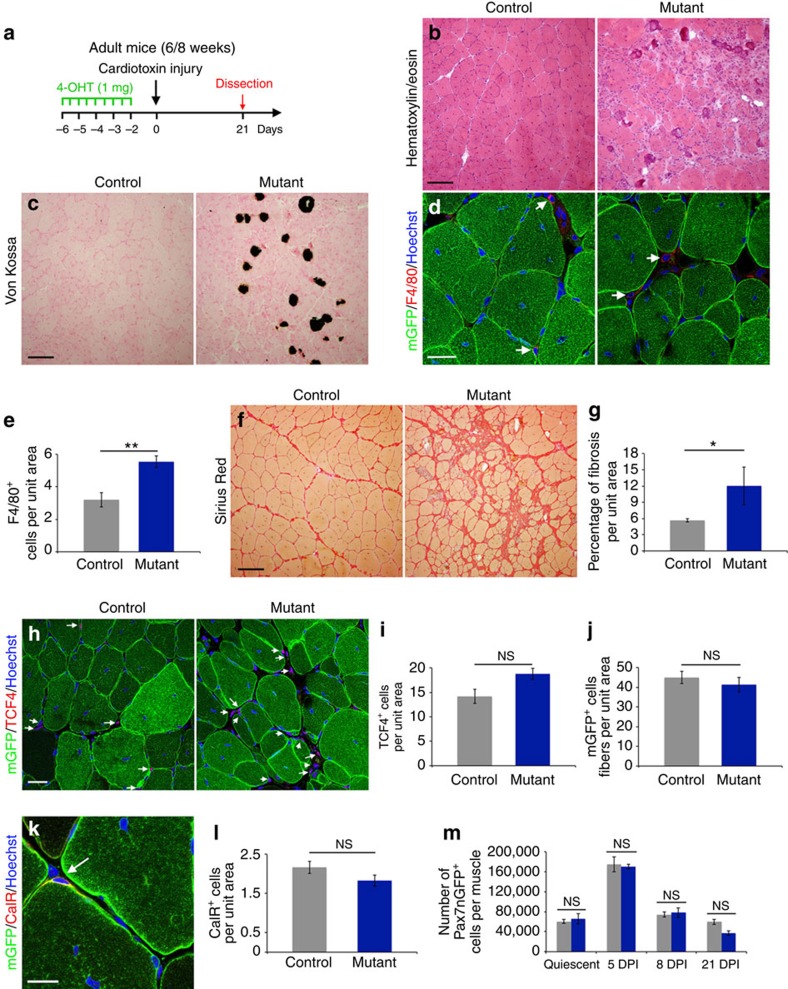
Incomplete regeneration following deletion of Numb:Numbl in satellite cells.(a) Strategy used to study TA muscle regeneration in the context of Numb:Numbl depleted satellite cells. Data were collected from transverse TA muscle cryosections of adult mice. (b) Histological staining with H&E. (c) Histological staining with Von Kossa. Dark precipitates reveal calcium deposits, a sign of chronic inflammation. (d) Immunofluorescence staining for macrophages (arrows) using anti-F4/80 antibody. (e) Quantification of the number of macrophages in (d); control: n=5 mice, 3.2±0.4 cells per unit area; mutant: n=5 mice, 5.6±0.4 cells per unit area; Mann-Whitney (MW) test P=0.079. (f) Histological staining with Sirius Red. (g) Quantification of fibrosis based on Sirius Red histology in (f); control: n=5 TA, 5 mice, 5.6±0.3% fibrosis per unit area; mutant: n=5 TA, 5 mice, 12±3.5% fibrosis per unit area; MW test P=0.0397. (h) Immunofluorescence staining for fibroblasts (arrows) using anti-TCF4 antibody. (i) Quantification of the number of fibroblasts in (h); control: n=4 mice, 14.2±1.4 cells per unit area; mutant: n=4 mice, 18.8±1.12 cells per unit area; MW test P=0.0571. (j) Quantification of the numbers of mGFP+ fibres; control: n=3 TA, 3 mice mice, 45±3.1 fibres per unit area; mutant: n=6 TA, 3 mice, 41.4±3.7 fibres per unit area; MW test P=0.2619. (k) Immunofluorescence staining for quiescent satellite cells (arrows) using anti-Calcitonin receptor antibody. (l) Quantification of quiescent satellite cells in (k); control: n=4 mice, 2.17±0.15 cells per unit area; mutant: n=4 mice, 1.83±0.14 cells per unit area; MW test P=0.20. (m) Quantification of the number Pax7nGFP+ cells in one diaphragm for quiescent cells; control: n=8 mice, 60,376±4,038; mutant: n=7 mice, 65,663±10,106; MW P=0.6943) and in 2 TA for activated cells (control 5 DPI: n=3 mice, 174,880±15,190; mutant 5 DPI: n=3 mice, 170,490±4,747, MW P>0.99; control 8 DPI: n=12 mice, 74,306±5,002; mutant 8 DPI: n=7 mice, 77,852±9,562, MW P=0.9671; control 21 DPI: n=3 mice, 59,935±5,284; mutant 21 DPI: n=4, 36,867±4,276, MW P=0.0571). Quantifications are presented as mean±s.e.m. Scale bars b,c,f: 100 μM; d,h: 25 μM; k: 20 μM. NS, not significant.